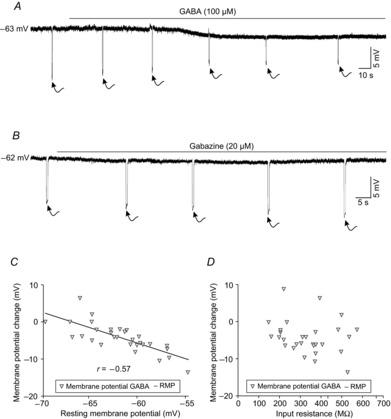
Effects of GABA (100 μm) or gabazine (20 μm) on the membrane potential and input resistance of MNs from the rat oculomotor nucleusA, bath application of 100 μm GABA yielded a membrane potential hyperpolarization and a diminution in the membrane response (see arrows) to negative current steps of 50 pA. B, gabazine produced an increase in the membrane response (see arrows) to negative current steps of 50 pA, while the RMP remained largely unaltered. C, relationship between RMP and membrane potential change evoked by 100 μm GABA. Note that the amplitude of membrane potential change diminished when rest values were close to −67 mV. D, relationship between input resistance and membrane potential change. MNs, motoneurons; RMP, resting membrane potential.